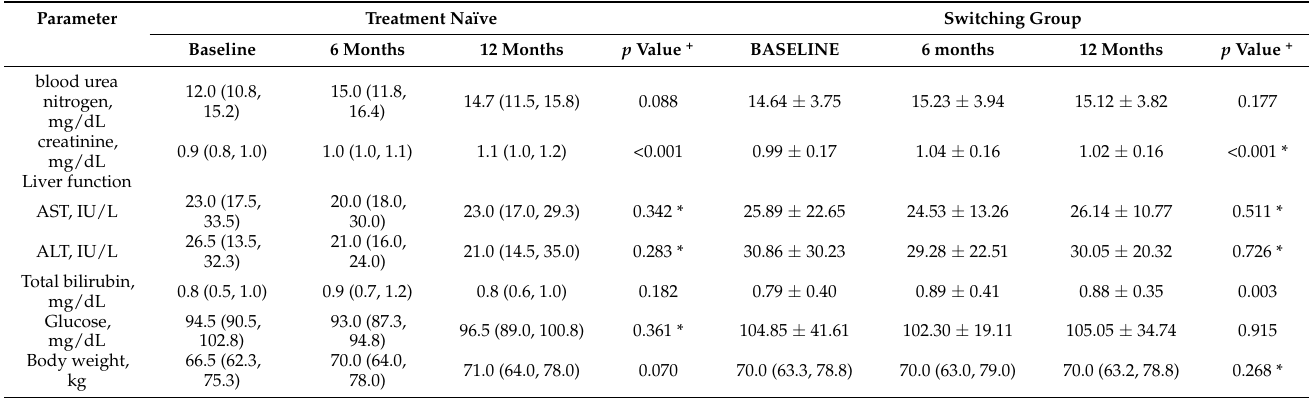
Geisser correction. + Using repeated measure ANOVA.